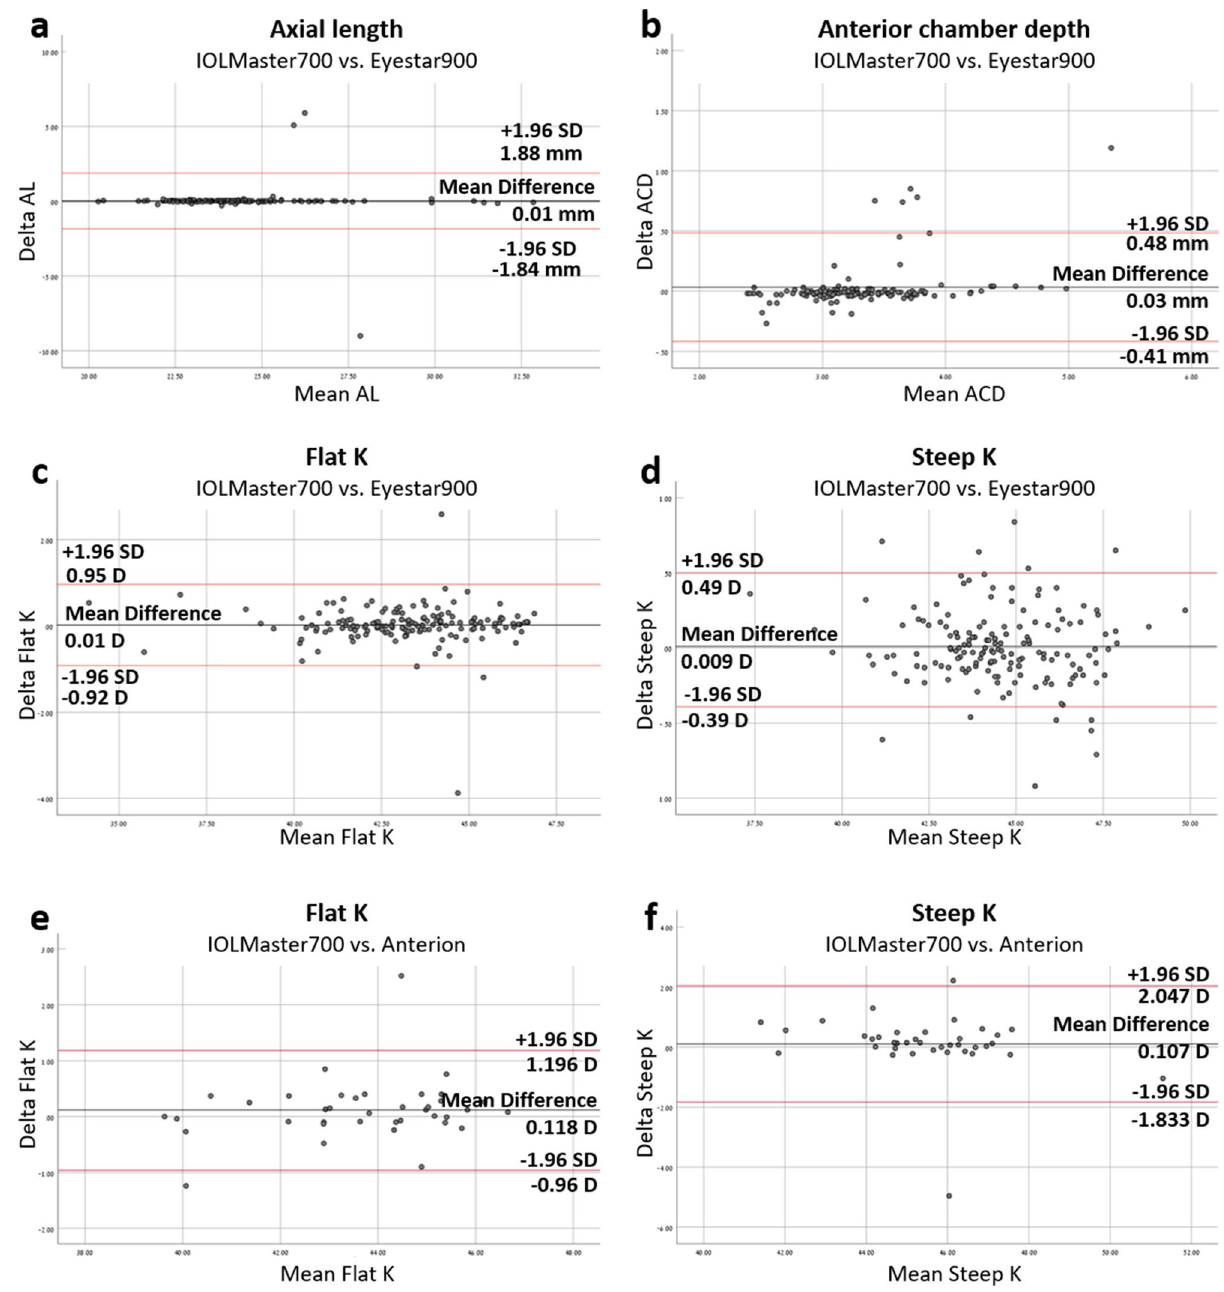
Figure 1. Bland and Altman agreement analysis of IOLMaster700, Eyestar900 and Anterion. Bland and Altman analysis of axial length, anterior chamber depth and flat and steep K in the IOLMaster vs. the Eyestar ( a – d ), and flat and steep K in the IOLMaster vs. the Anterion ( e , f ). Axial length and anterior chamber depth are measured in millimeters, and flat and steep K in diopters. ( a ) No significant difference between IOLMaster and Eyestar scatter dots in axial length measurements, P = 0.54. ( b ) Significant difference between IOLMaster and Eyestar scatter dots in anterior chamber depth measurements, P < 0.001. ( c ) No significant difference between IOLMaster and Eyestar scatter dots in flat K measurements, P = 0.69. ( d ) No significant difference between IOLMaster and Eyestar scatter dots in steep K measurements, P = 0.21. ( e ) No significant difference between IOLMaster and Anterion scatter dots in flat K measurements, P = 0.23. ( f ) No significant difference between IOLMaster and Eyestar scatter dots in steep K measurements, P = 0.18. D Diopters, ACD anterior chamber depth, AL Axial